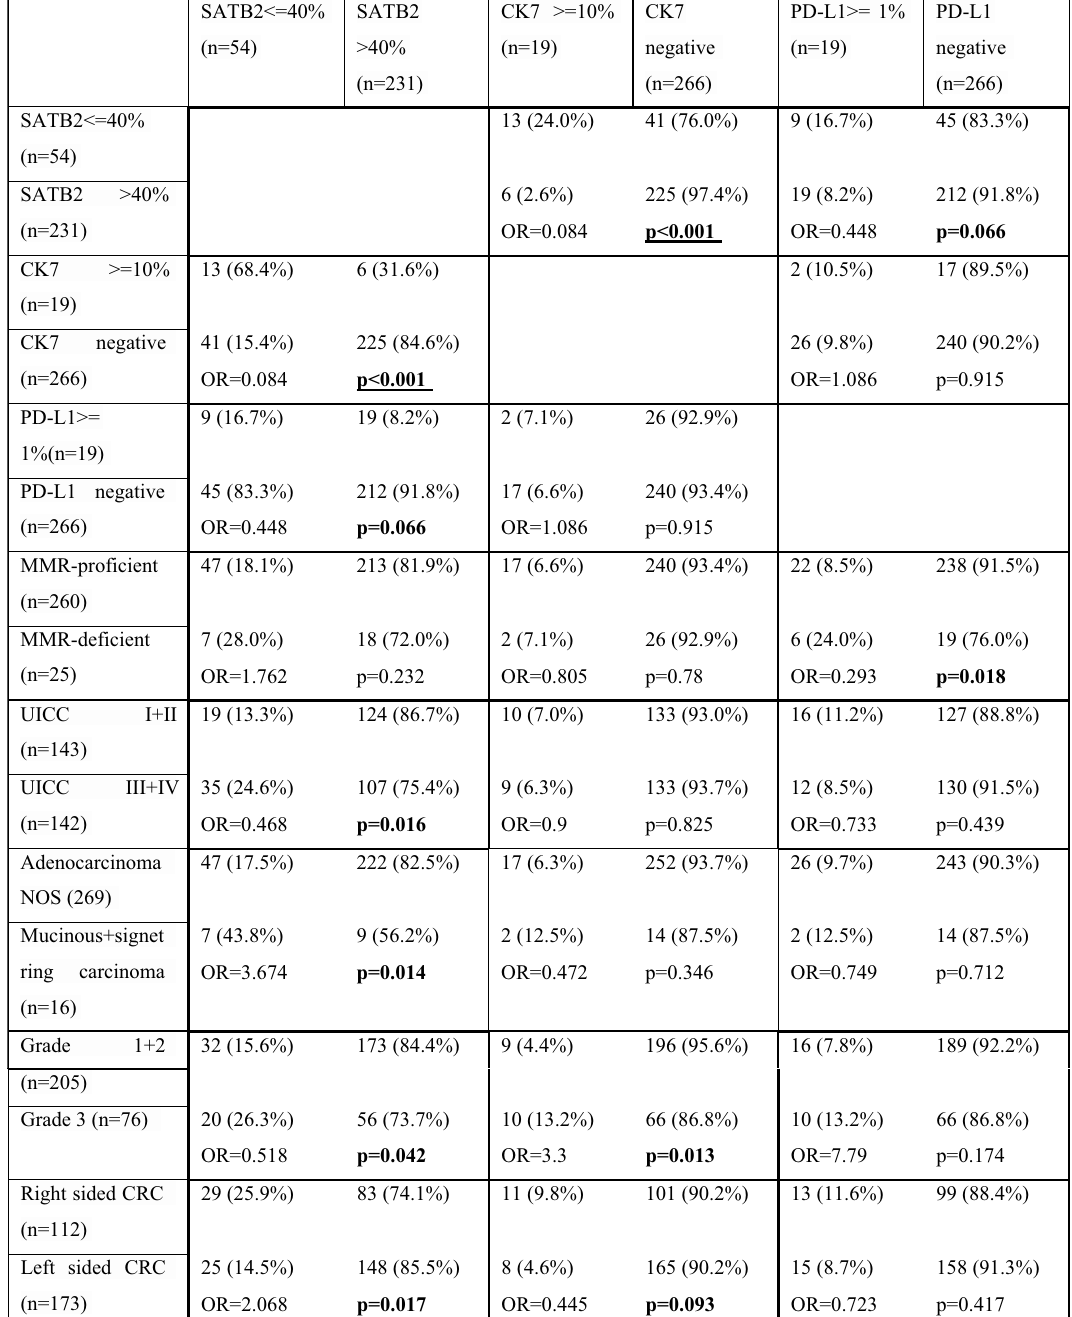
Table 3. Results of logistic regression, significant and borderline insignificant associations are in bold, the main findings of the study are in bold and underlined—association of CK7 expression and SATB2